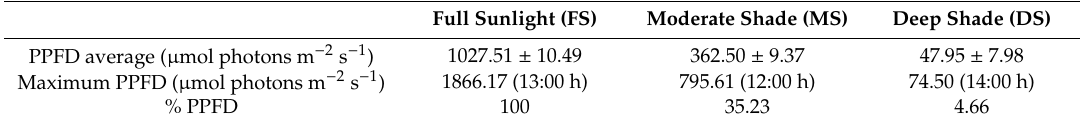
Table 2. Daily PPFD (photosynthetic photon flux density) average, maximum PPFD observed, average percentage of full sunlight under three light